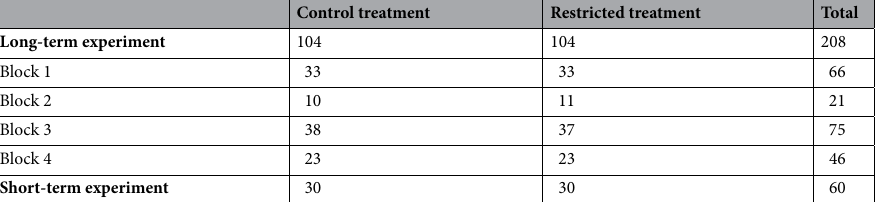
relaxed conditions for oviposition after the treatment period. We counted the number of eggs (fecundity) depos- ited on the substrate within these vials and the number of adults emerging from them (reproductive success) to estimate the productivity of isolated females immediately after exposure to the two experimental manipulations. Eggs (hatched or unhatched) are clearly visible on the surface of beans at all times and we counted them 11 days after females were removed to avoid any potential impact on first instars larvae 26 .